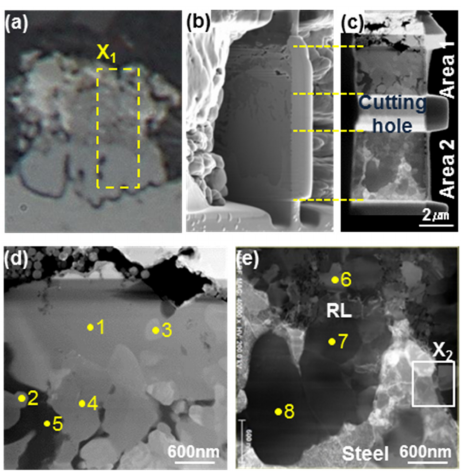
Figure 5. ( a ) 10 s hot-dipped specimen; ( b ) TEM images of the specimen obtained for the area denoted as X 1 in ( a ) using FIB and ( c ) specimen divided into two areas; ( d – e ) The microstructures of areas 1 and 2 in ( c ), respectively.